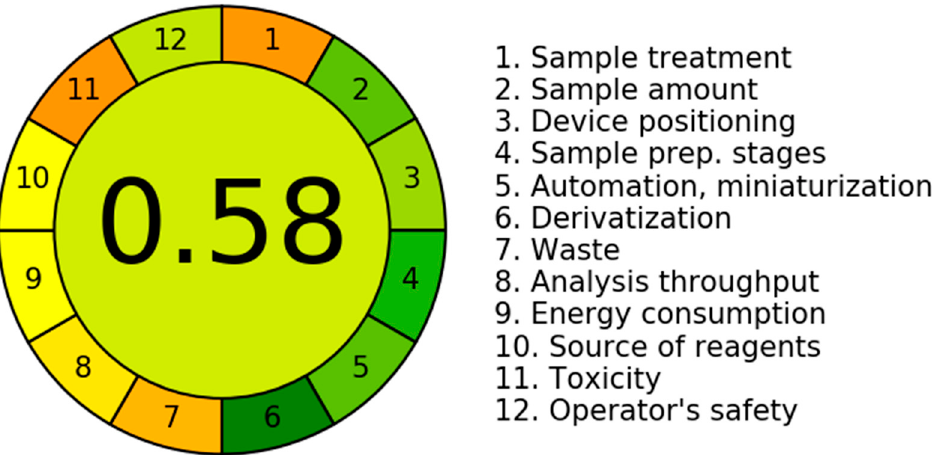
Figure 7. Calculated greenness of the method.